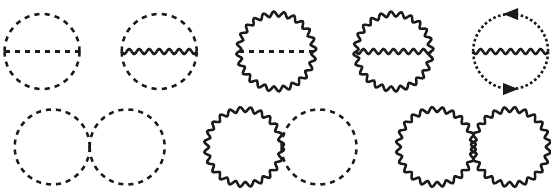
Figure 10. 2-loop topologies contributing to the 3d V e(cid:11) , in Landau gauge. Sunset-type diagrams on the (cid:12)rst row are divergent in the UV and exactly determine the RG evolution of the mass parameters in the 3d